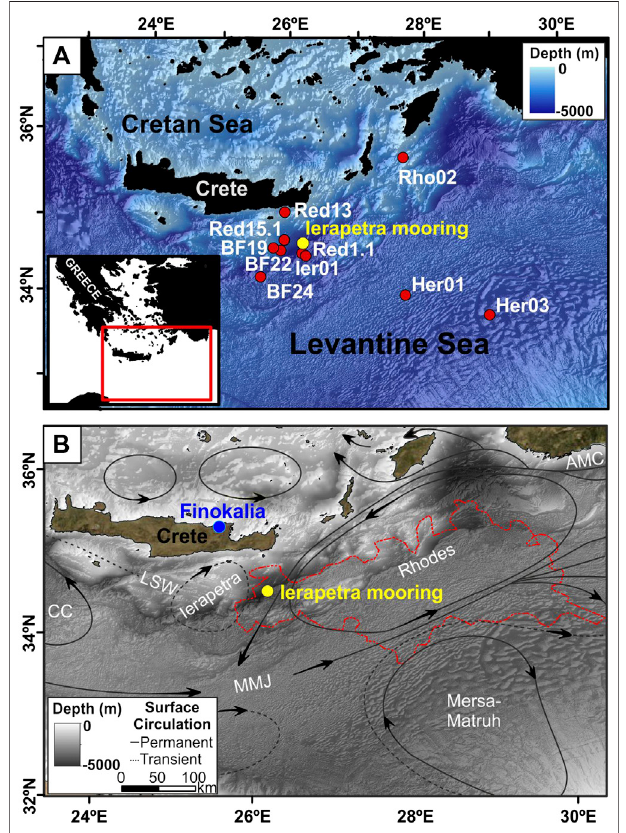
FIGURE 1 | (A) Location of the mooring line deployed in the deep Ierapetra Basin from June 2010 to June 2013 (yellow dot), and 10 surface sediment samples collected in the Levantine Sea (red dots) reported by Pedrosa-Pàmies et al. (2015) (lipid data for sediment samples BF19, BF22 and BF24 are not available). (B) Schematic representation of the upper thermocline circulation in the study area (Robinson and Golnaraghi, 1993), and location of Ierapetra mooring (yellow dot), and Finokalia atmospheric station (blue dot). Circulation patterns and water masses: MMJ-Mid- Mediterranean Jet, AMC-Asia Minor Current, LSW-Levantine Surface Water, CC-Cretan Cyclone. The dashed red polygon is the contour of the Rhodes Gyre phytoplankton bloom of March 2012 as indicated by Chlorophyll- a concentrations above 0.2 mg m − 3 (48291.3 km 2 ). The bathymetric map was produced using metadata from the EMODnet Bathymetry portal — http:// www.emodnet-bathymetry.eu.